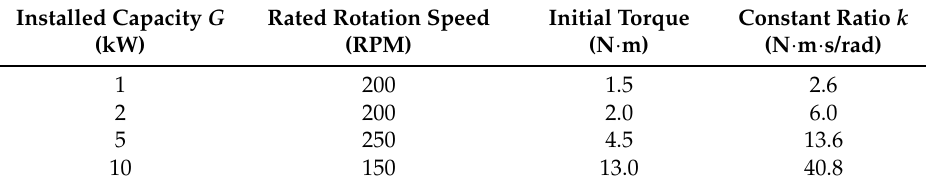
Table 2. Calculating parameters for different